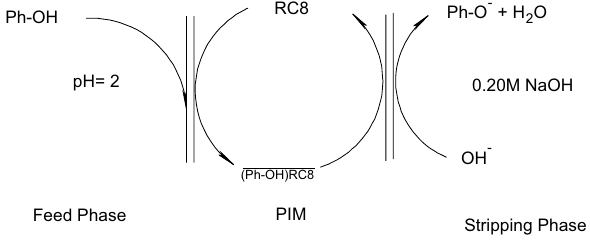
Fig. 8 Mechanism scheme for the transport of phenol from acidic aqueous solution to alkaline stripping phase using PIM with calix[4] resorcinarene